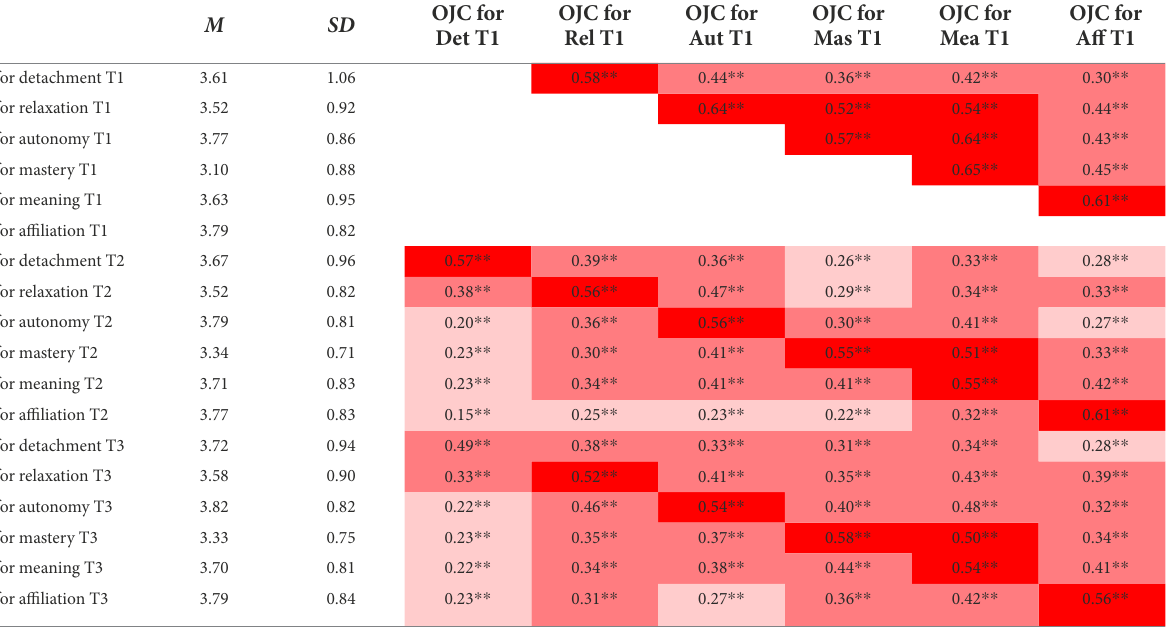
TABLE 5 Intercorrelations of the OJC dimensions, Study